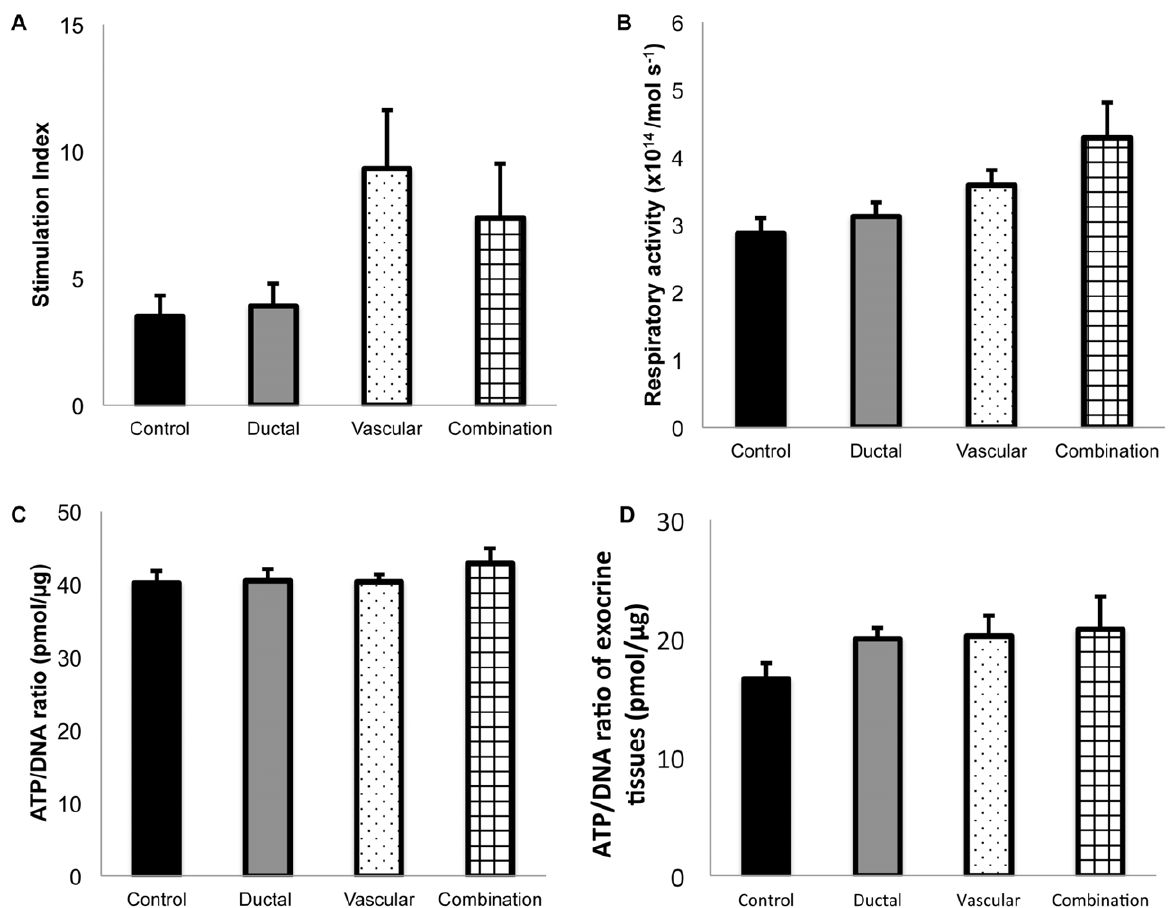
Figure 4. The effects of ductal injection and/or vascular perfusion on the function and viability of islets. A SGS test of islets isolated (A) was performed to evaluate the influence of cold ischemic stress on islet function. To examine the influence of cold ischemic stress on islet viability, the respiratory activity (B) and the ATP/DNA ratio (C) of isolated islets were measured. In all assays performed, no significant differences were detected among the groups. The ATP/DNA ratios of the exocrine tissues after cold preservation are shown (D). No significant differences were detected among the groups.